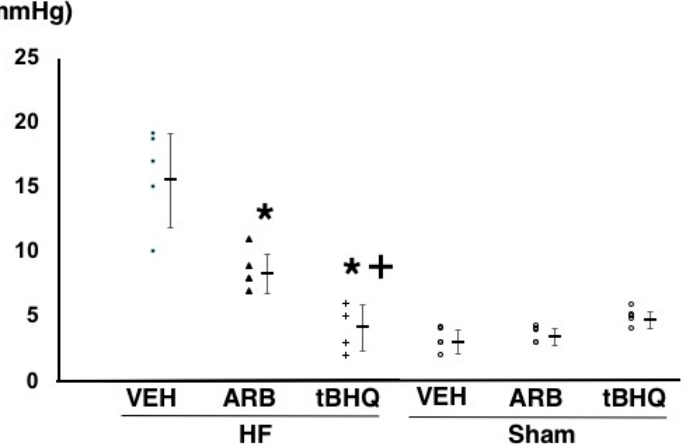
Figure 3. Left atrial pressure of heart failure treated with intracerebroventricular (ICV) infusion of vehicle (HF-VEH), or with ICV infusion of angiotensin II type 1 receptor blocker (HF-ARB), or with ICV infusion of nuclear factor erythroid 2-related factor 2 activator, tert -butylhydroquinone (HF-tBHQ), or sham treated with ICV infusion of VEH, or with ICV infusion of ARB, or with ICV infusion of tBHQ. n = 5 for each group. All data are shown in dot plot and mean ± standard deviation. * p < 0.05 vs. HF-VEH in HF-ARB and HF-tBHQ. + p < 0.05 vs. HF-ARB in HF-tBHQ.